Question: How would you classify this visualization?
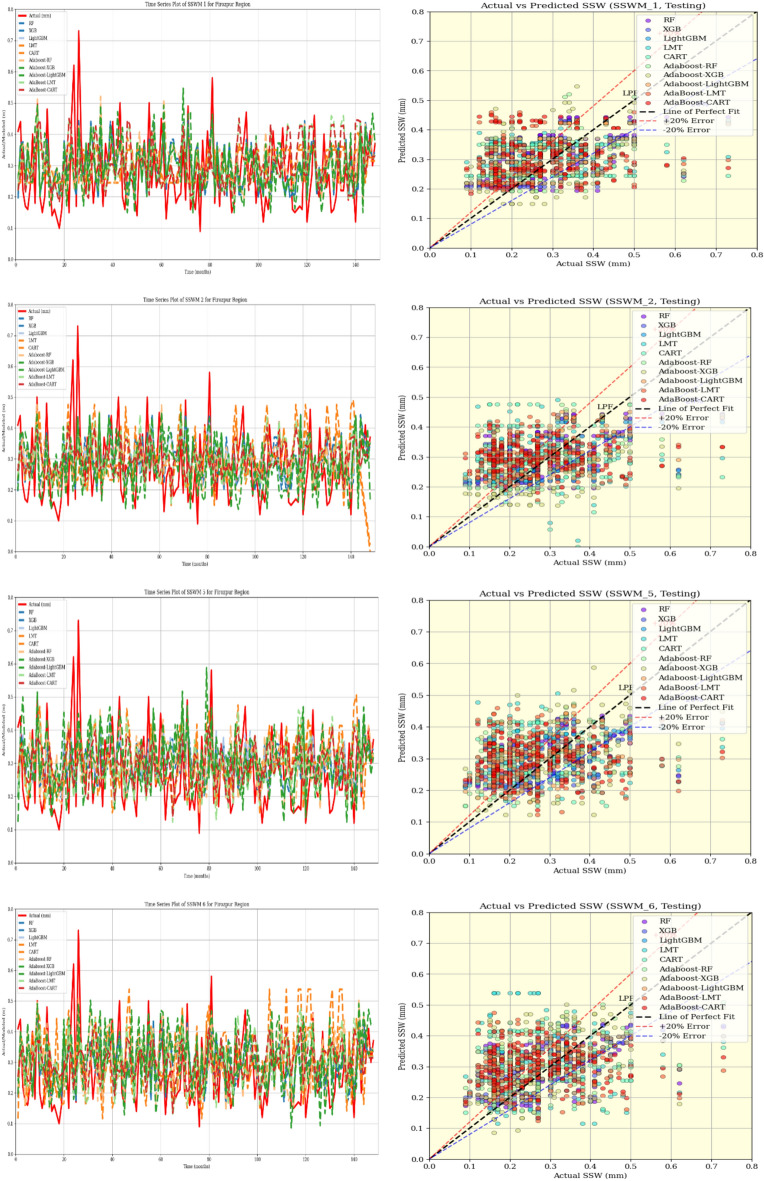
Answer: scatter